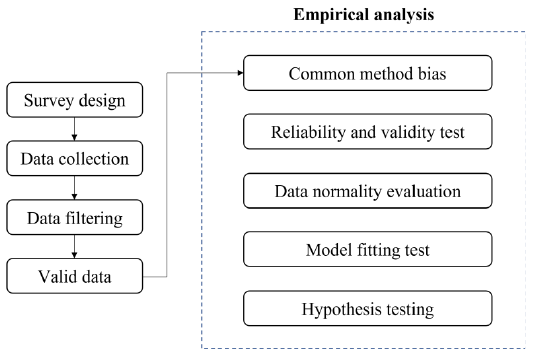
Figure 2. The overview of the methodology.